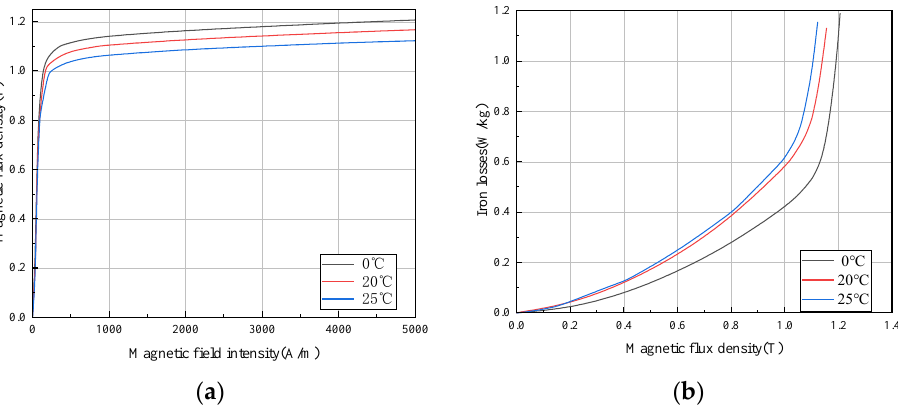
Figure 5. Magnetic properties of grain-oriented silicon steel at different temperature fields ( a ) magnetization curves of H-80 @ 50 Hz and 0 Mpa ( b ) iron loss curves of H-80 @50 Hz and 0 Mpa.